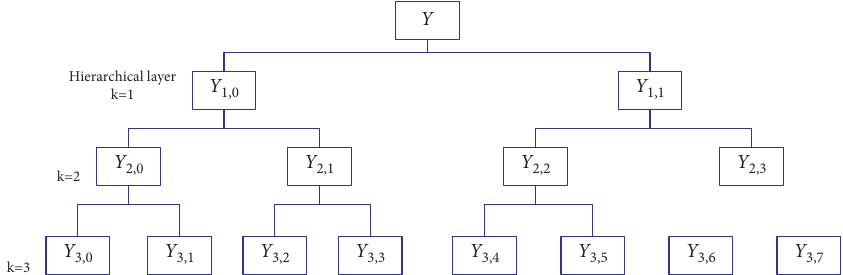
Figure 1: Schematic diagram of hierarchical decomposition when k � 3.